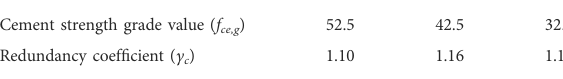
TABLE 6 Redundancy coef fi cient of cement strength grade value ( γ c ). Cement strength grade value ( f ce,g )